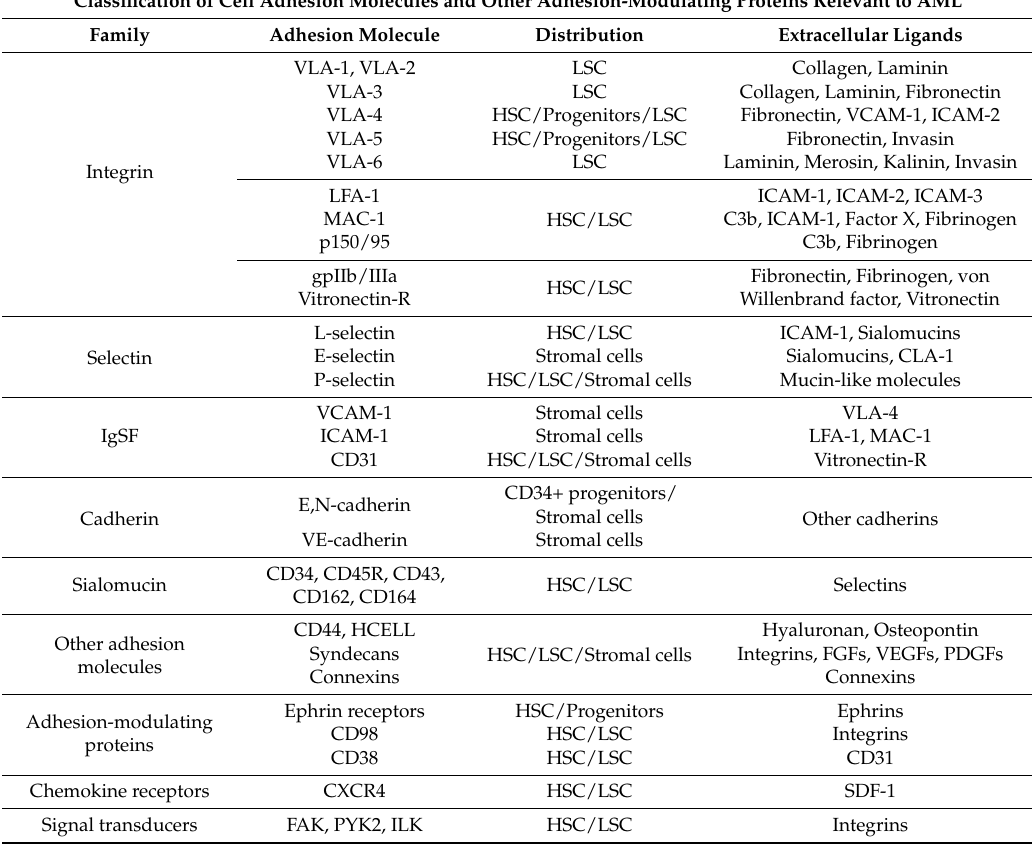
Table 1. Summary of the adhesion molecules discussed in this review. All abbreviations as detailed in the text, C3b, complement 3b, and FGF, fibroblast growth